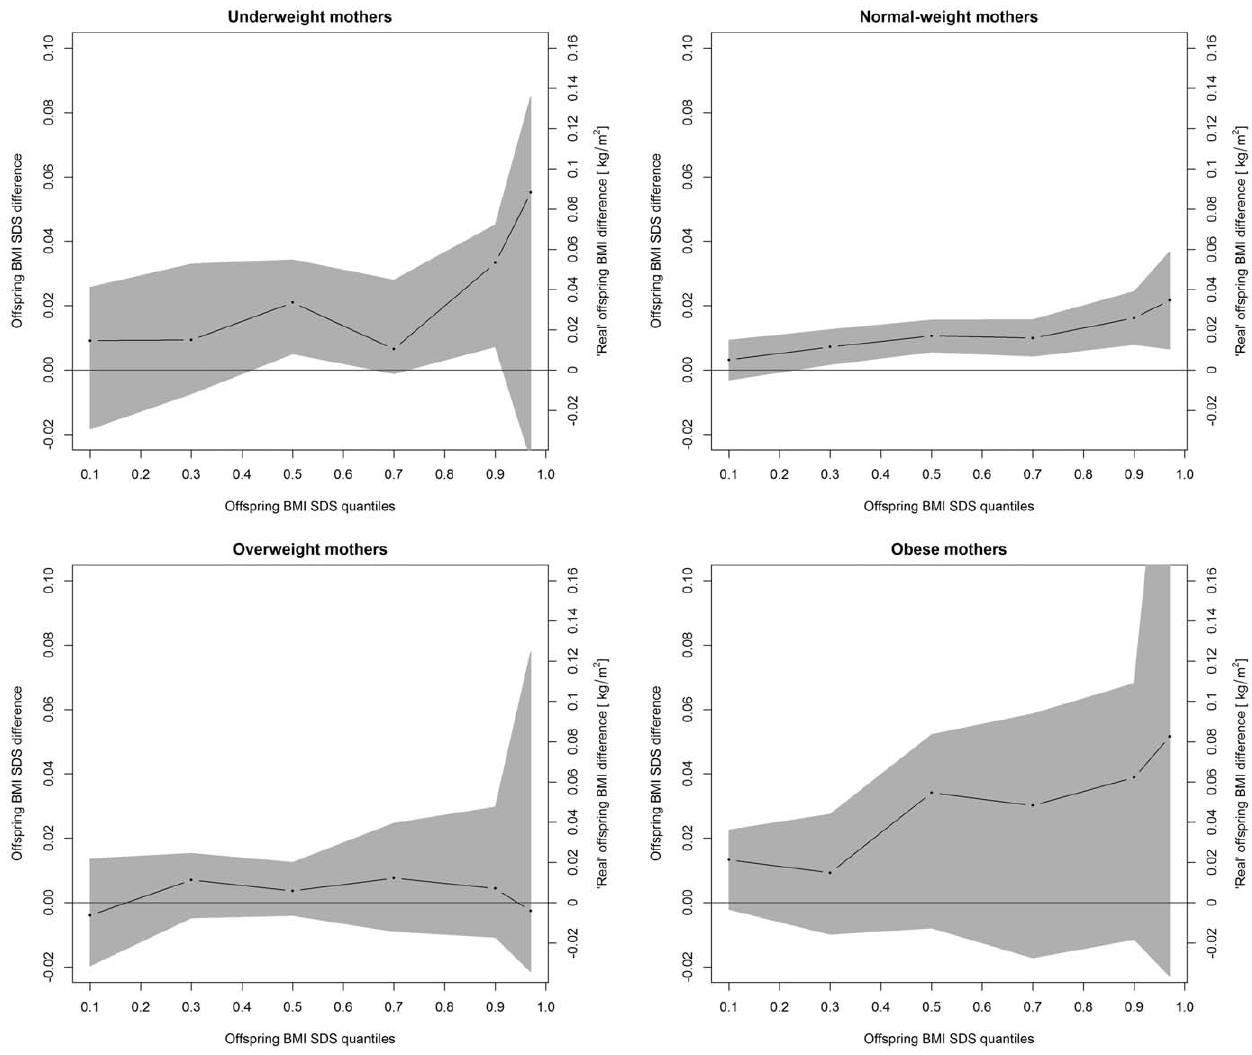
Figure 1. Quantile regression estimates and 95% confidence bounds (grey areas) for the associations of total gestational weight gain (GWG) with selected quantiles of offspring’s BMI SDS at 5–6 years (adjusted models). The dots represent quantile regression estimates at the 0.1, 0.3, 0.5, 0.7, 0.9 and 0.97 quantiles of BMI SDS and are connected by dashes to visualise trends by BMI SDS quantiles. A horizontal line depicts the y=0